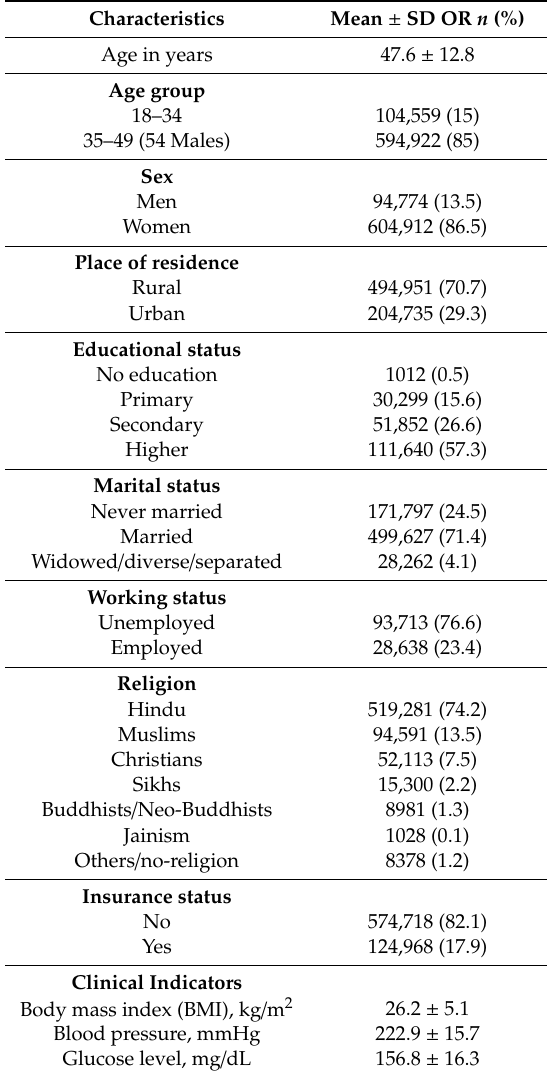
Table 1. General characteristics of the study